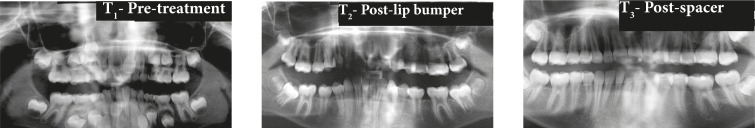
Panoramic radiographs of one of five patients who had second molar
impaction. Spacer treatment was performed on this case.